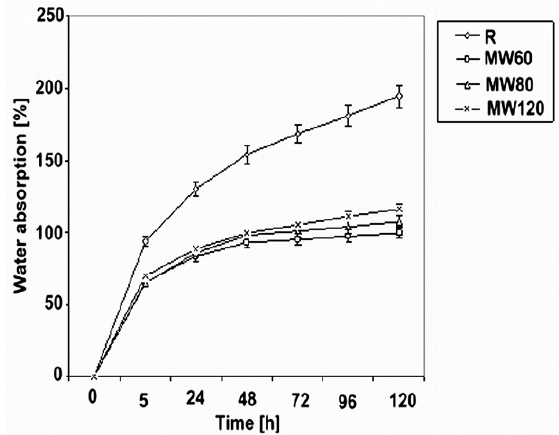
Figure 4. Water absorption of non-modified and modified softwood with SA.